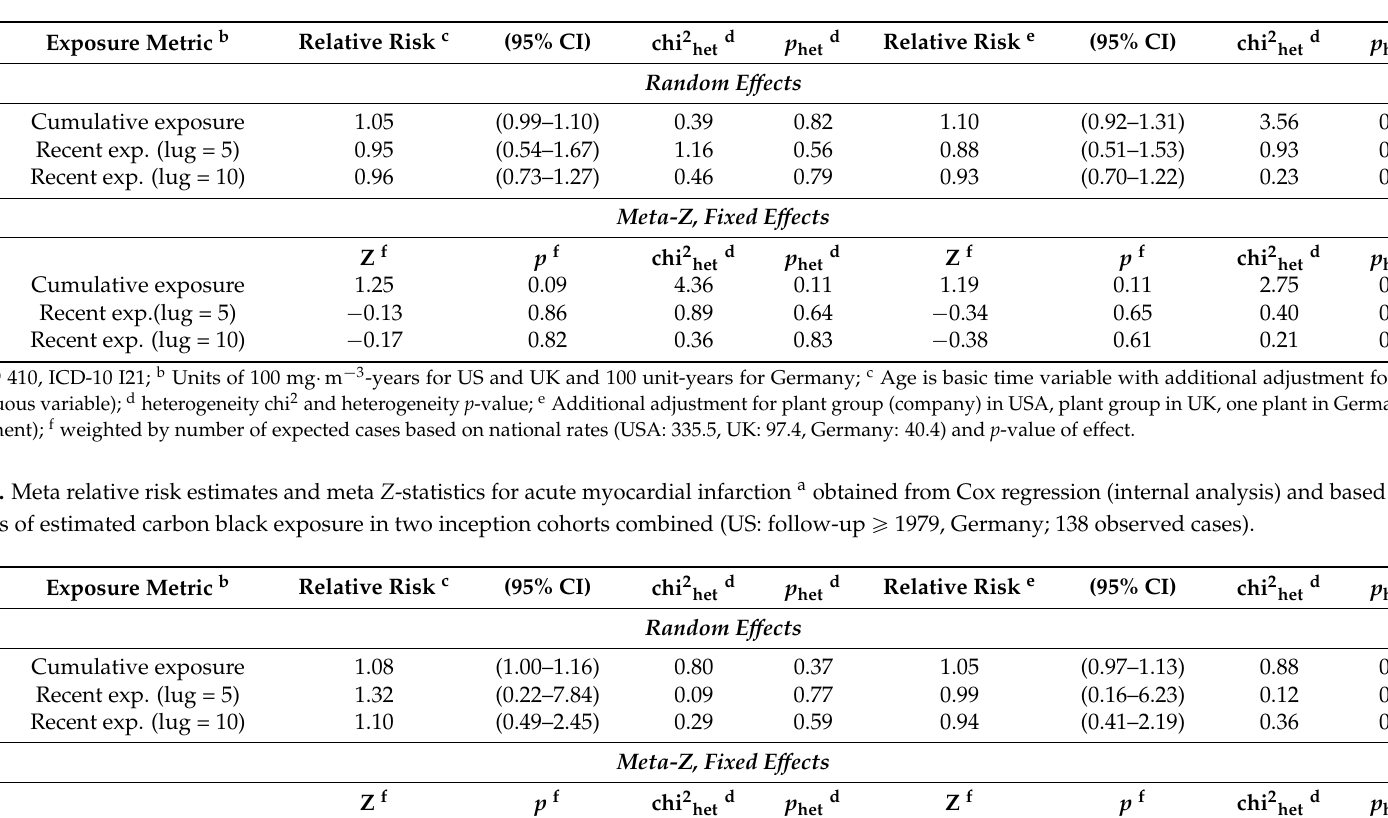
Table 11. Meta relative risk estimates and meta Z -statistics for acute myocardial infarction a obtained from Cox regression (internal analysis) and based on continuous measures of estimated carbon black exposure in three full cohorts combined (US, UK, Germany; 432 observed cases).